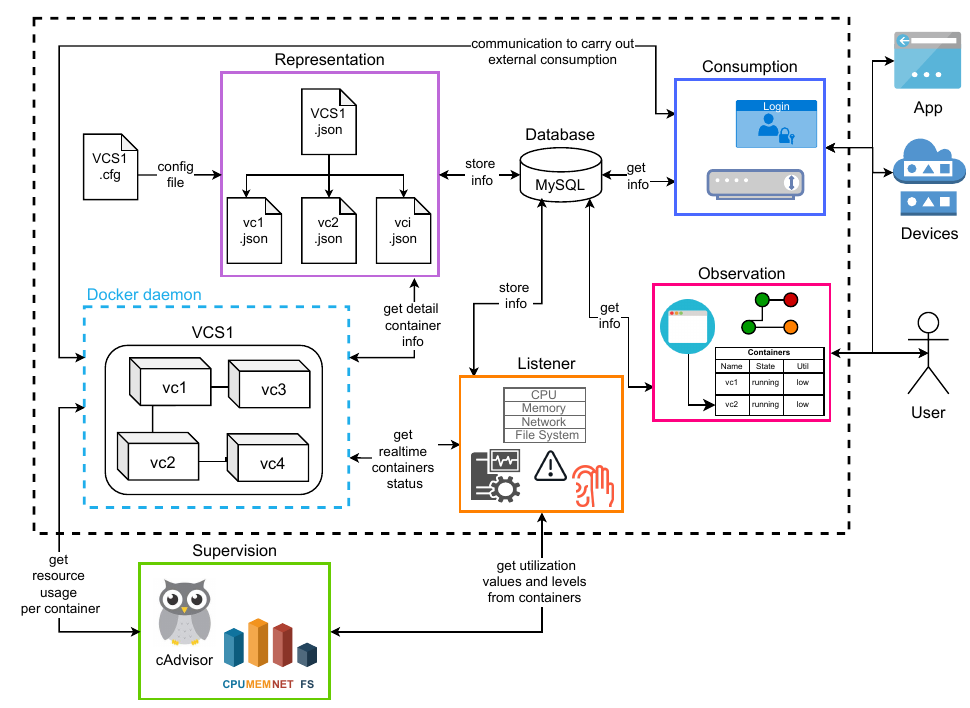
Figure 4. Components of DST